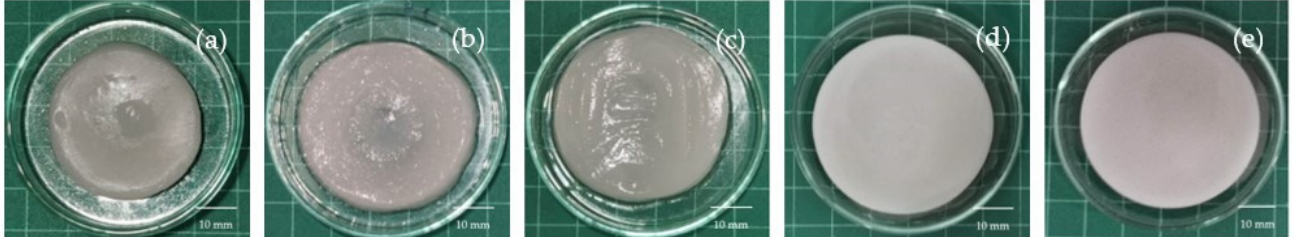
Figure 4. The appearance of WHC-composited hydrogels: C 1 A 0.5 P 0.5 ( a ), C 1.5 A 0.5 P 0.5 ( b ), C 2 A 0.5 P 0.5 ( c ), C 2.5 A 0.5 P 0.5 ( d ), and C 3 A 0.5 P 0.5 ( e ). Table 1. The thickness and diameter of WHC-hydrogels.